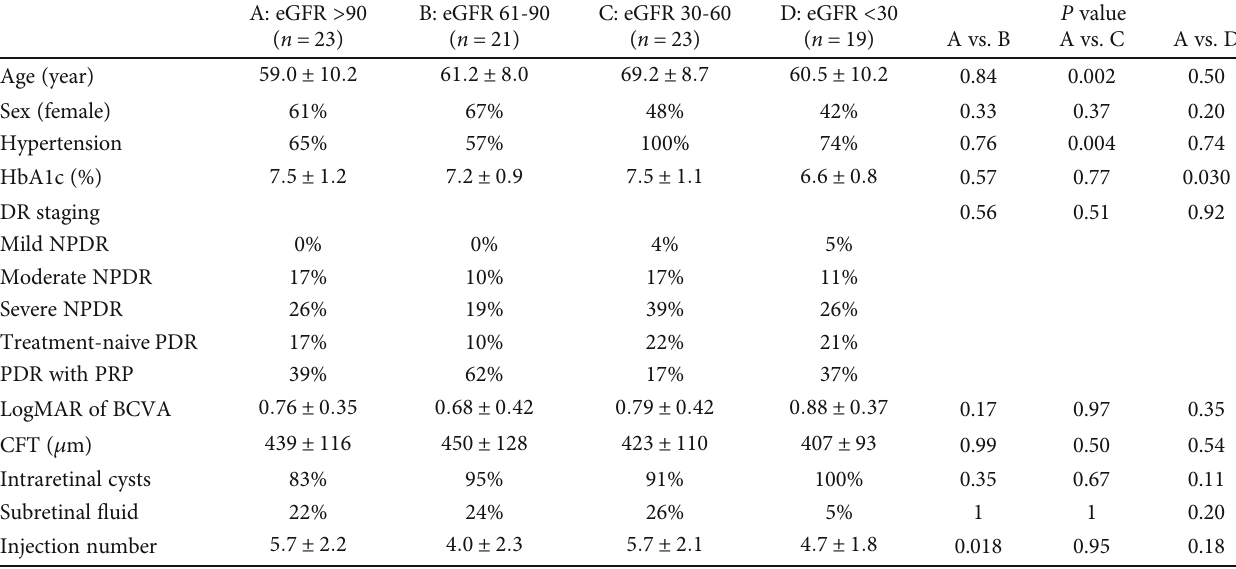
Table 2: Demographic data, visual acuity, and optical coherence tomography characteristics in four di ff erent eGFR groups at baseline.